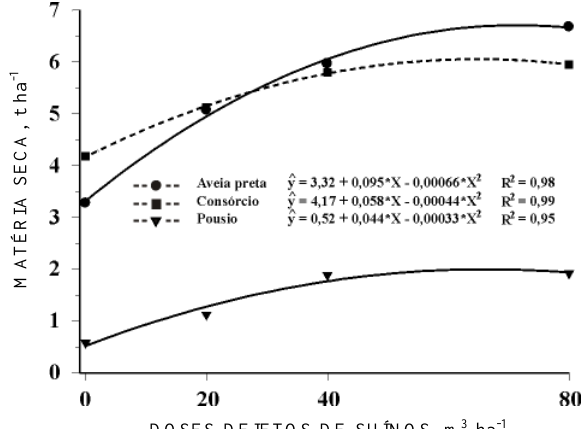
DOSES DEJETOS DE SUÍNOS, m 3 ha Figura 3. Produção de matéria seca das plantas de cobertura e da vegetação espontânea (pousio) com o uso de dejetos de suínos nas doses de 0, 20, 40 e 80 m 3 ha -1 . * Significativo a 5 %.